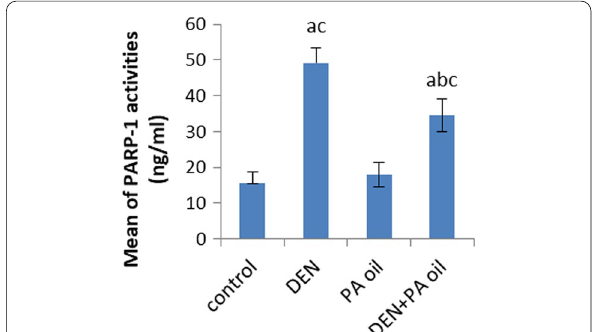
Fig. 4 Effect of PA oil on liver tissue PARP‑1 concentration in rats subjected to induced hepatotoxicity. The values are expressed as mean SD ( n 6). a Significant to normal control group ( P ± = = b Significant to DEN group ( P 0.05) c Significant to PA oil group = ≤ = ( P ≤